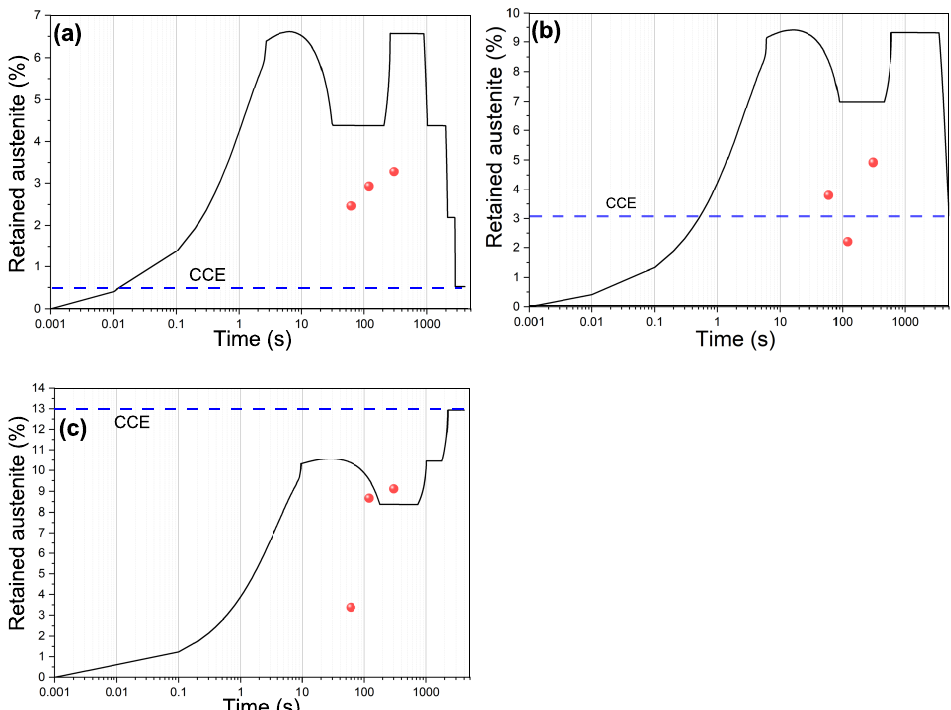
Figure 5. Simulated volume fraction of the stable retained austenite as a function of partitioning time at ( a ) 330 ◦ C, ( b ) 310 ◦ C, and ( c ) 292 ◦ C, and the corresponding experimental result of RA. The dashed blue line denotes the carbon concentration in RA calculated under CCE